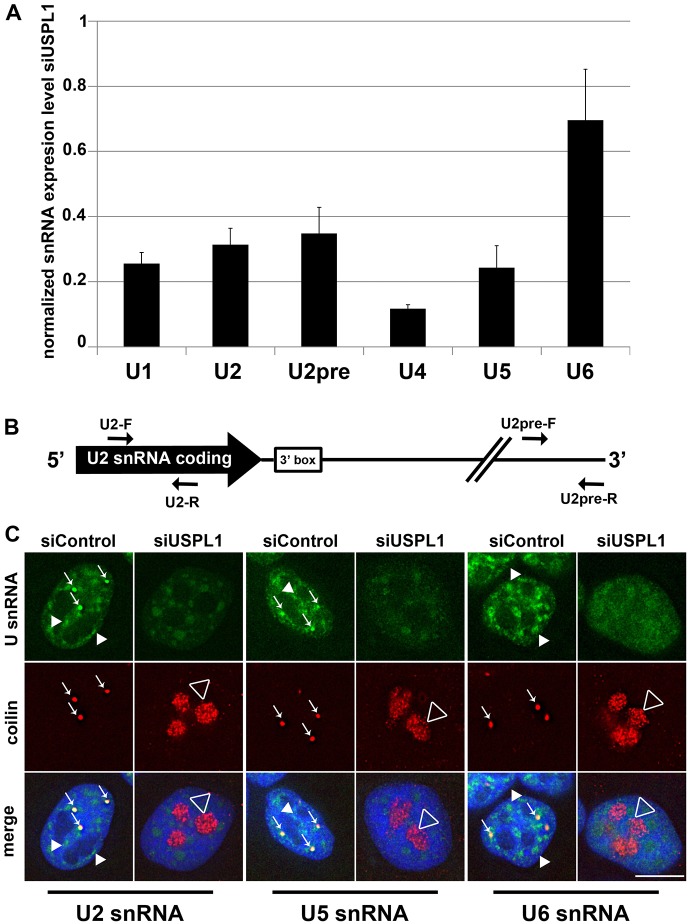
Cellular snRNA levels are reduced upon knockdown of USPL1. (A) qRT-PCR for different major U snRNA species in HeLa cells treated with siRNA against USPL1. U2pre represents the unprocessed U2 snRNA. Respective expression levels were normalised for levels of β-actin and snRNA levels of siControl-treated cells were set to 1. Bars represent the s.e.m. of four independent experiments, each measured in technical replicates of 2. (B) Schematic representation of the initial U2 snRNA transcript (adapted from Broome and Hebert, 2012) depicting additional 634 bp after the end of the U2 snRNA coding sequence and the position of the respective primers for qRT-PCR used for U2 snRNA in A. (C) HeLa cells treated with control siRNA or siRNA against USPL1 were subjected to RNA-FISH for U2, U5 and U6 snRNA using Alexa-Fluor-488-labelled probes. The immunostaining against coilin was used to monitor the efficiency of the siRNA treatment against USPL1. Cajal bodies are indicated by arrows, splicing speckles by arrowheads and nucleolar coilin by an open arrowhead. Scale bar: 10 µm.